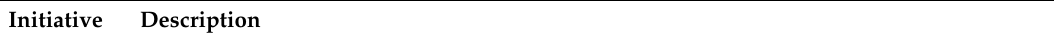
Table 1. Description of